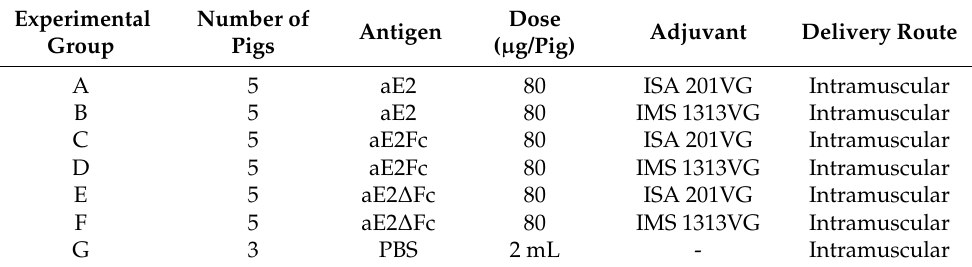
Table 1. Experimental